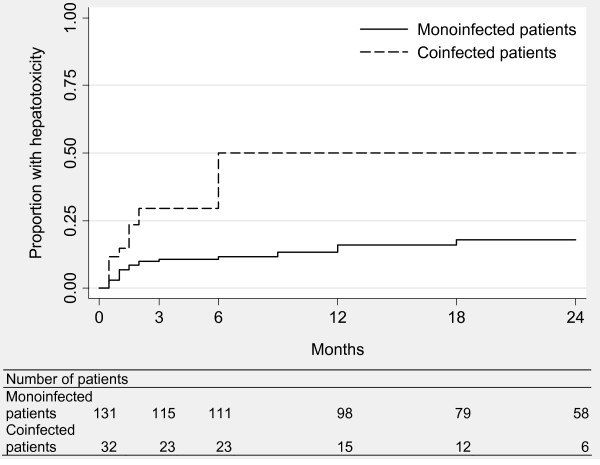
Proportion of patients who experienced episodes of grade ≥ 2 hepatotoxicity by infection group.